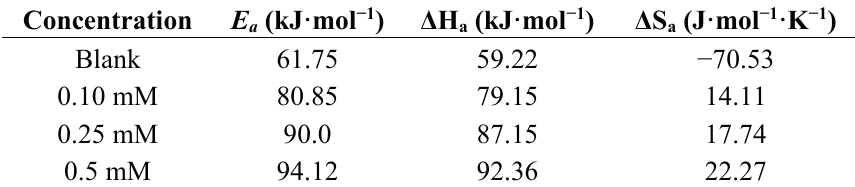
Table 1. Corrosion kinetic parameters for mild steel in 1.0 M HCl in the presence and absence of